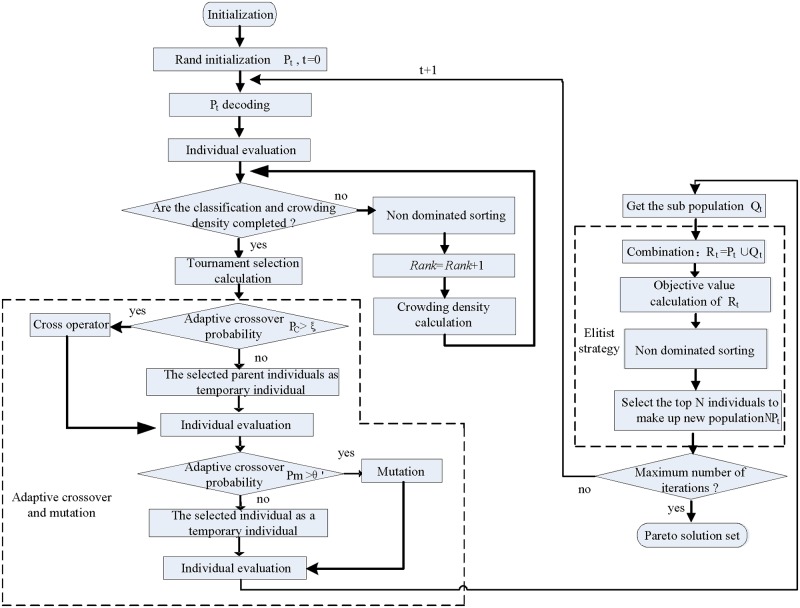
Improved NSGA-II.